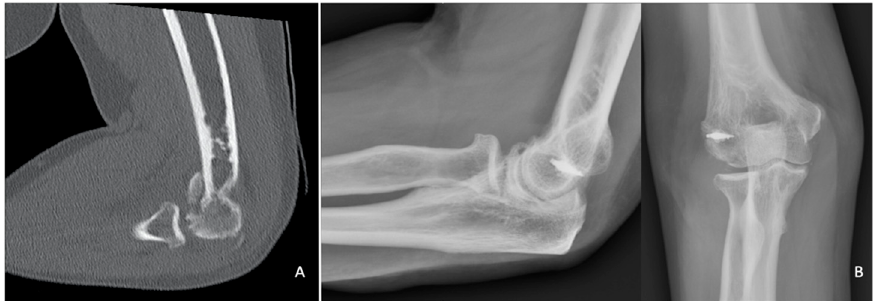
Figure 7. ( A ) Preoperative CT scan and ( B ) post-operative X-rays of a Bryan–Morrey Type II fracture treated with fragment excision and lateral collateral ligament repair using a suture anchor.